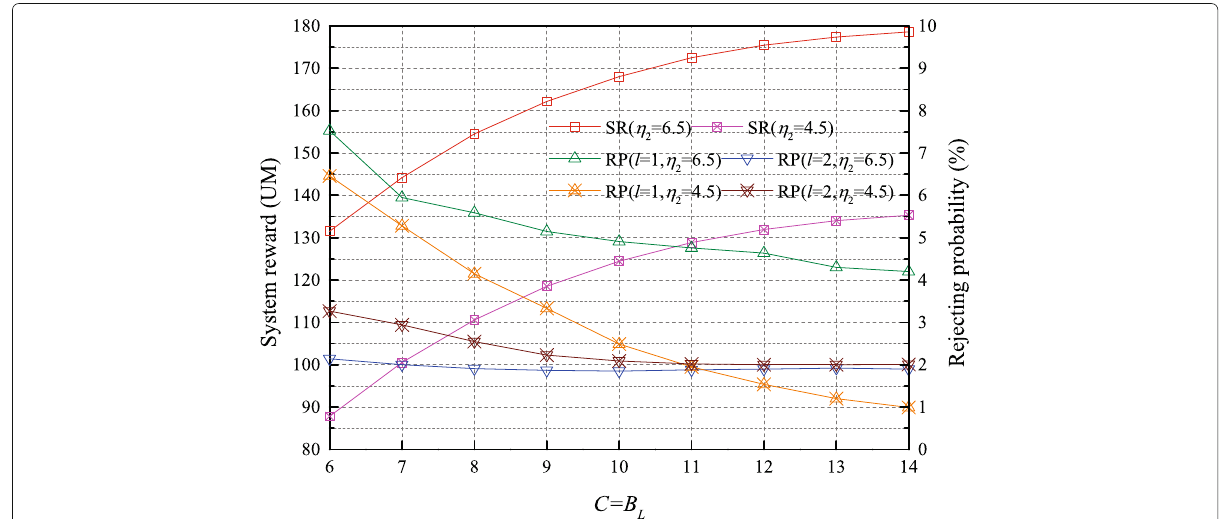
Fig. 11 SR and RPs under different lower bounds of resources. This figure shows the impact of the lower bounds of resources on the evaluation results